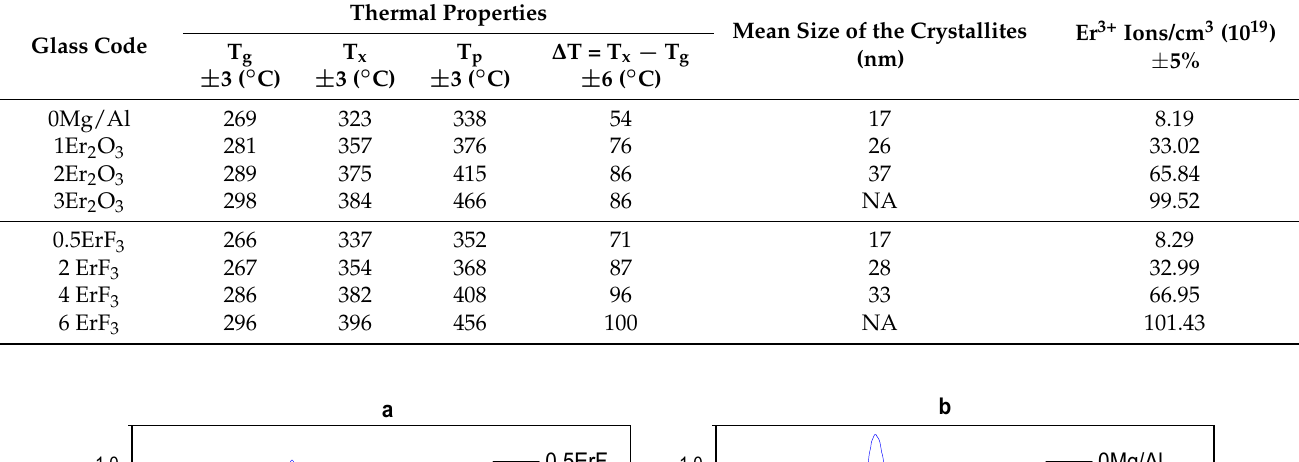
Table 3. Thermal properties of the investigated glasses (NA: the peak intensity is too small to estimate the size of the crystallites). Note that the 0Mg/Al corresponds to 0.25Er 2 O 3 glass.